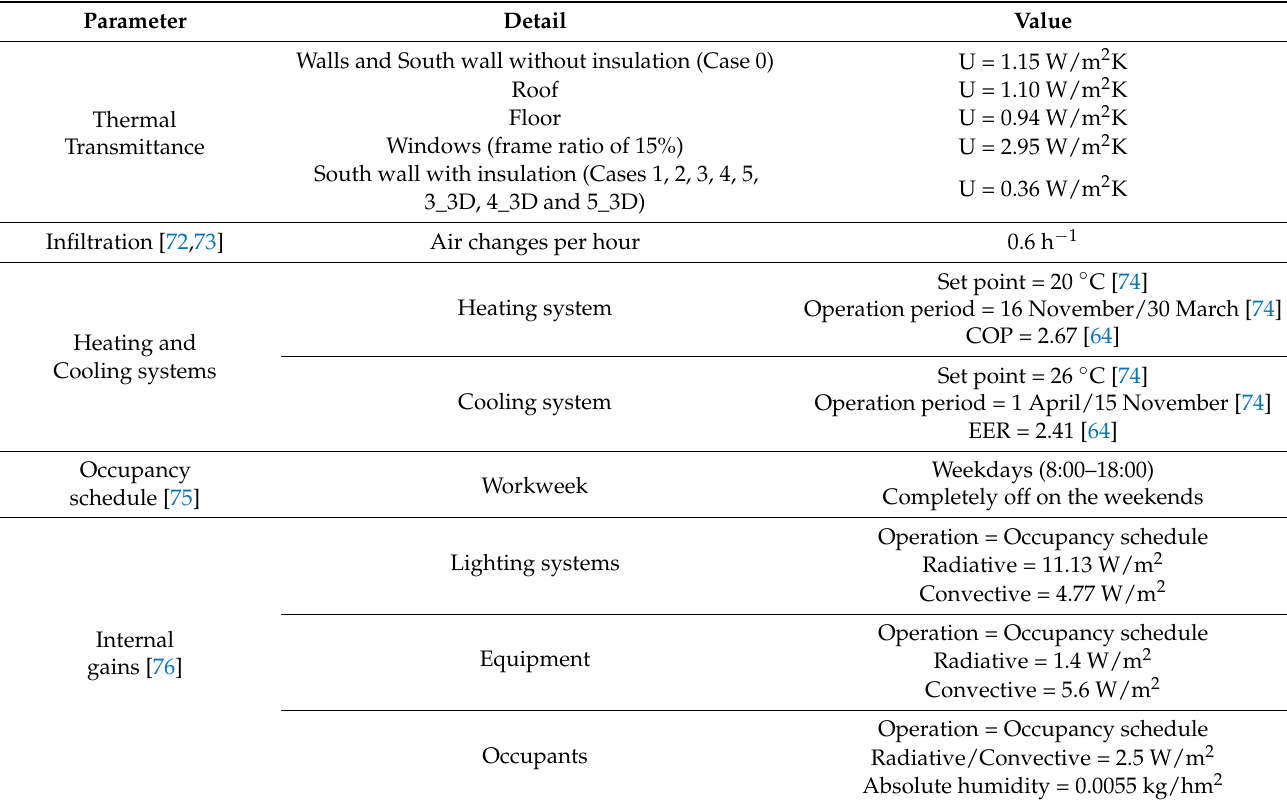
Table 5. Simulation parameters used in this